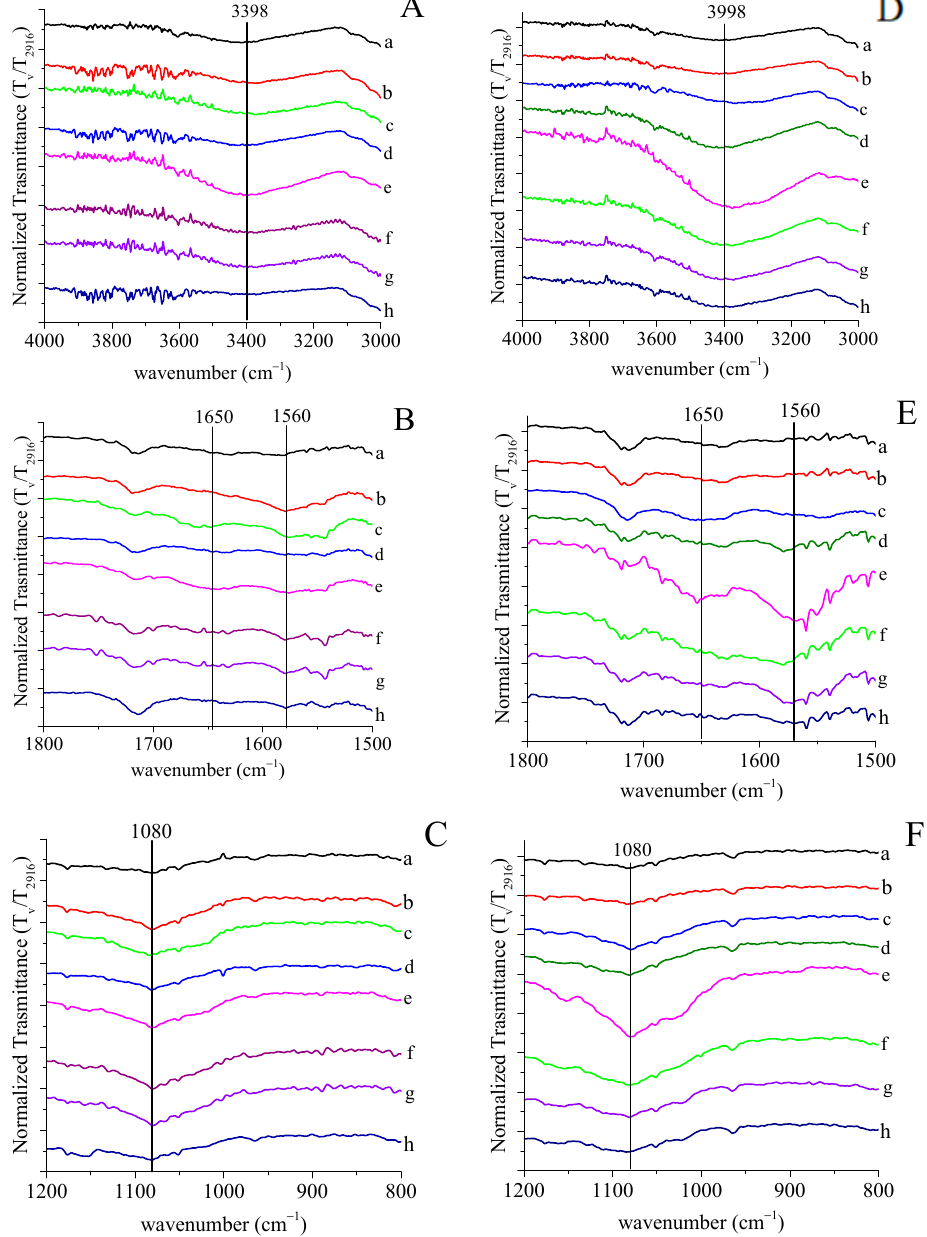
Figure 2. ATR–FTIR spectra (in different regions of infrared absorption bands characteristic of chitosan) of irradiated HDPE at 50 ( A – C ) and 100 kGy ( D – F ) after different grafting reaction times: ( b ) 30 min, ( c ) 1 h, ( d ) 2 h, ( e ) 3 h, ( f ) 5 h, ( g ) 10 h, and ( h ) 15 h. Line ( a ) represents irradiated HDPE.